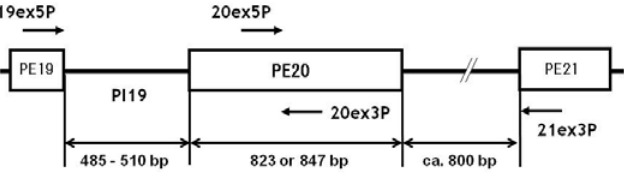
Fig. 1 - DNA fragments containing intron 19 (PI19) and exon 20 (PE20) of PolA1 gene were amplified using a pair of 19ex5P (PE19) and 21ex3P (PE21) primers. The sequences were determined by direct sequencing using primers for the initial amplification and internal sequence primers, 20ex5P and